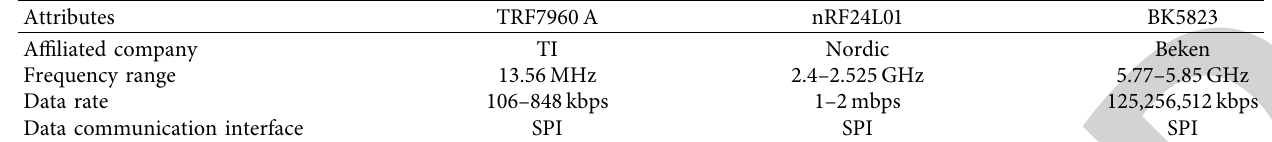
Table 1: Comparison of wireless communication front-end parameters.